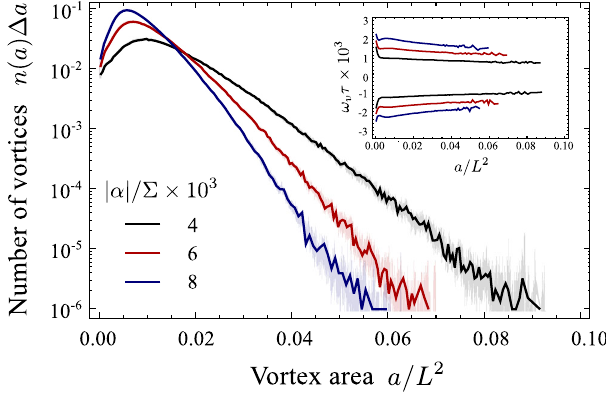
FIG. 2. Number of vortices n ð a Þ Δ a (with Δ a=L 2 ¼ 1 . 5 × 10 − 5 ) with area in between a and Δ a as a function of a , obtained, in extensile systems, from a numerical integration of Eq. (1) for various α values. The shaded regions surrounding the curves correspond to the statistical error obtained from five simulations with different (disordered) initial conditions. The data show a < a < L , prominent exponential distribution in the range a min with a the area of the smallest active vortex. Inset: Average min vorticity of an individual vortex as a function of its area.